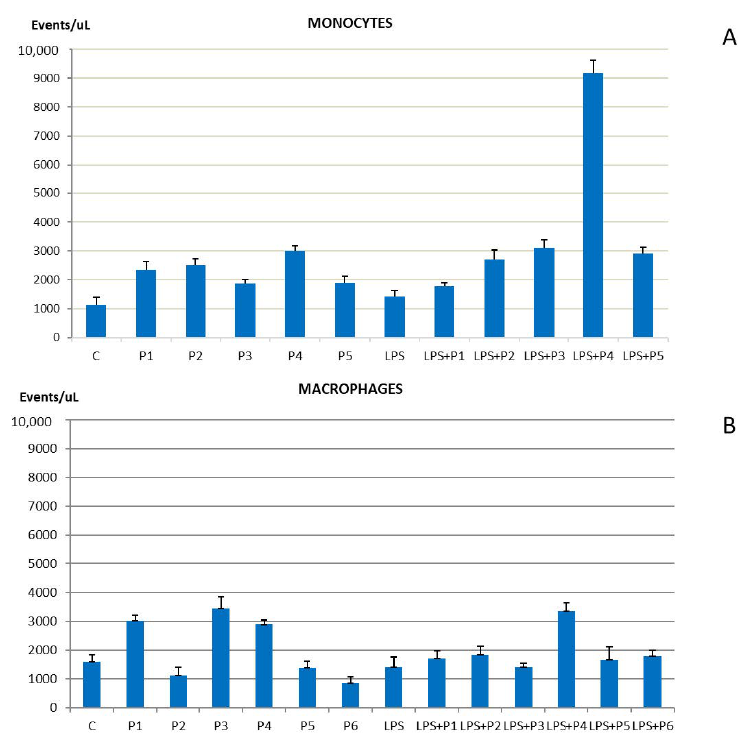
Figure 1. Extracellular vesiclescount through cytofluorimetric analysis on monocites ( A ) and macrophages ( B ). Extracellular vesicles represent shuttles capable of carrying nucleic acid molecules (DNA and RNA) or proteins out of the cell. Extracellular vesicles concentration generally reflects inflammatory or proliferative mechanisms and it is a function of mitogenic activity. Bar graphs show the mean values of three independent experiments.